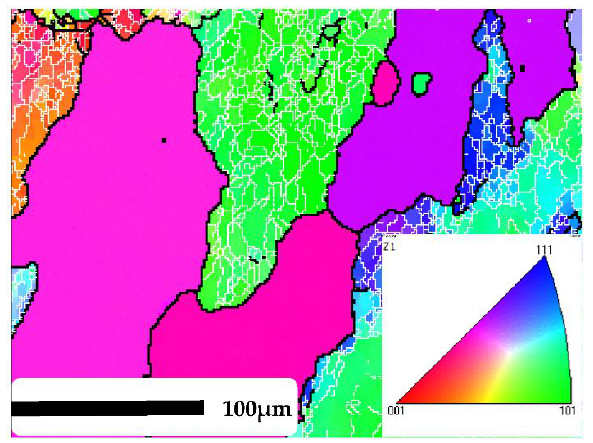
Figure 1. The electron backscattered diffraction (EBSD) micrograph of 2219 Al alloy before deformation.